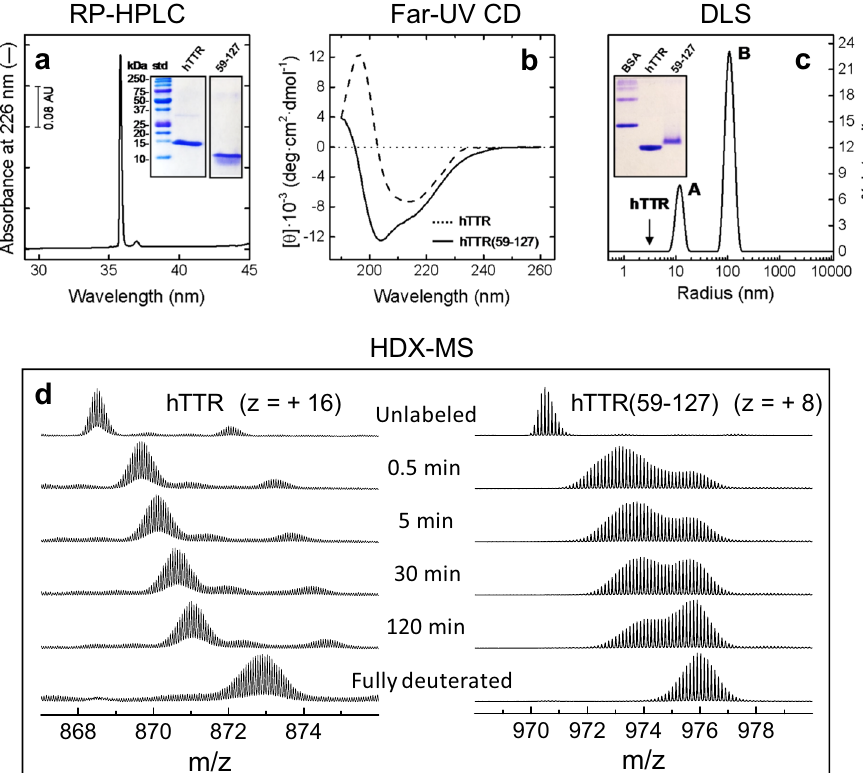
Fig. 6 Puri fi cation and characterization of hTTR(59 – 127). a RP-HPLC purity check of hTTR(59 – 127). After lyophilisation, an aliquot of puri fi ed fragment was dissolved in 10 mM phosphate buffer, pH 7.4 and immediately injected onto an analytical C18 column, eluted (0.8 ml/min) with an acetonitrile-0.1% TFA gradient from 10 to 45% in 30 min. (Inset) SDS-PAGE (4 – 20% acrylamide) analysis of puri fi ed hTTR(59 – 127) (5 μ g) under reducing conditions and Coomassie staining. For comparison, puri fi ed intact hTTR was also analysed. b Far-UV circular dichroism. Spectra of puri fi ed full-length hTTR and hTTR (59 – 127) fragment were recorded at a protein concentration of 0.1 mg/ml in 10 mM phosphate buffer, pH 7.4, at 25 °C. c DLS analysis. DLS measurements were carried out at a fragment concentration of 0.23 mg/ml. The arrow indicates the size of intact hTTR tetramer. DLS data are expressed as % intensity size distribution, while the values of R h , %mass distribution and %PD are reported in the Supplementary Table 1. All measurements were carried out at 25 °C, immediately after dissolving hTTR(59 – 127) protein lyophilisate with phosphate buffer. Inset Native PAGE (5 – 12% acrylamide) of hTTR and hTTR (59 – 127) fragment (5 μ g). For comparison, BSA was also loaded. d HDX-MS kinetics of deuterium uptake by intact hTTR (left panel) and hTTR(59 – 127) fragment (right panel). Proteins were incubated at 25 °C with 90% D 2 O in PBS buffer, pH 7.4, and m/z spectra were taken at increasing labeling time. For intact hTTR, the multiple charged species ( z = + 16) of S-Cys-hTTR (MW = 13,880.8 Da) was considered, whereas for hTTR(59 – 127) the deuterium uptake of the z = + 8 species was monitored. For hTTR at t = 0, the species with m / z = 872.05 corresponds to the S-Cys-Gly-hTTR isoform (i.e., species 2:i in the Supplementary Fig. 1). A detailed description of the experimental procedure and data analysis is reported in the Supplementary Information. For clarity, the intensity of m 0 and m 100 spectra was downscaled by 4-fold, compared to the intensity of m t